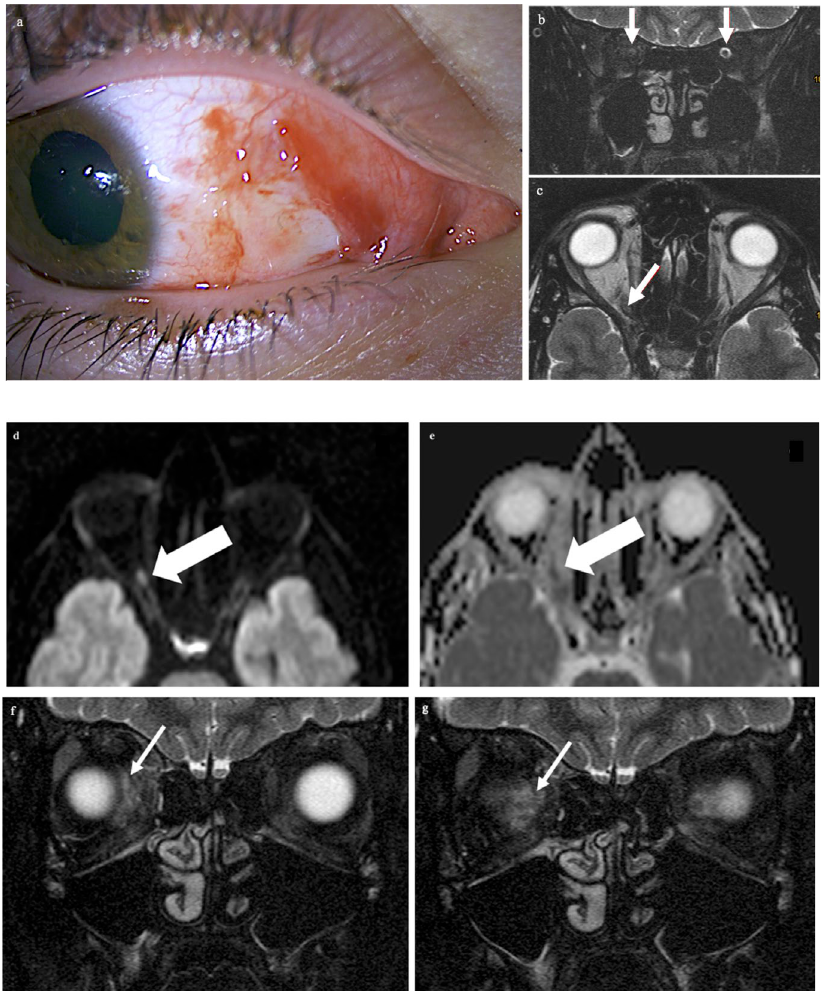
Figure 1. Examination of the right eye revealed a superficial conjunctival wound nasally and a dilated pupil ( a ). On the MRI scan, there is loss of the subarachnoid space in the right optic nerve (arrows in panel ( b ): the subarachnoid space of the left optic nerve is normal). The respective transverse T2-weighted image shows a central signal increase in the optic nerve (arrow in ( c )). On the diffusion-weighted imaging, a punctuate signal increase in the optic nerve in the same location is seen (arrow in ( d )); the corresponding ADC map shows signal loss in the same location (arrow in ( e )). The globe as well as the left eye and orbit are unchanged, while there is a diffuse signal increase (arrows) in the right retrobulbar space nasally ( f , g ).